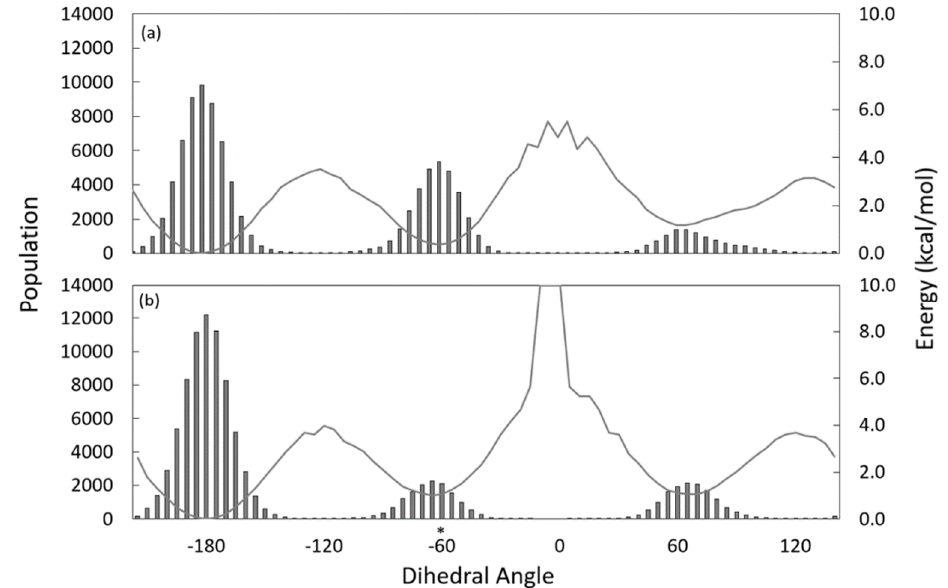
Figure 3. Distribution of the dihedral angle of the stearoyl-CoA formed by the 8th, 9th, 10th and 11th carbon atoms with corresponding free energy. Results for the five simulations grouped by ( a ) substrate when in the protein; ( b ) substrate when in waterbox. Asterix indicates the −60° dihedral angle that favors the desaturation reaction.